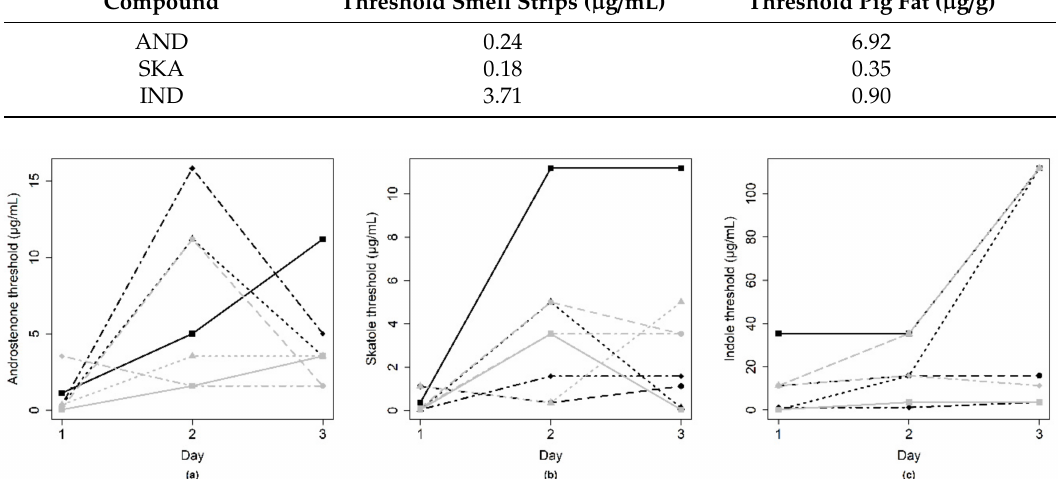
Figure 6. Sensory threshold on smell strips, with each line representing the individual thresholds ( y -axis) of a panelist for replicate tests on three di ff erent days ( x -axis). For all compounds, ( a ) androstenone, ( b ) skatole, ( c ) indole, the thresholds varied considerably within and between panelists.